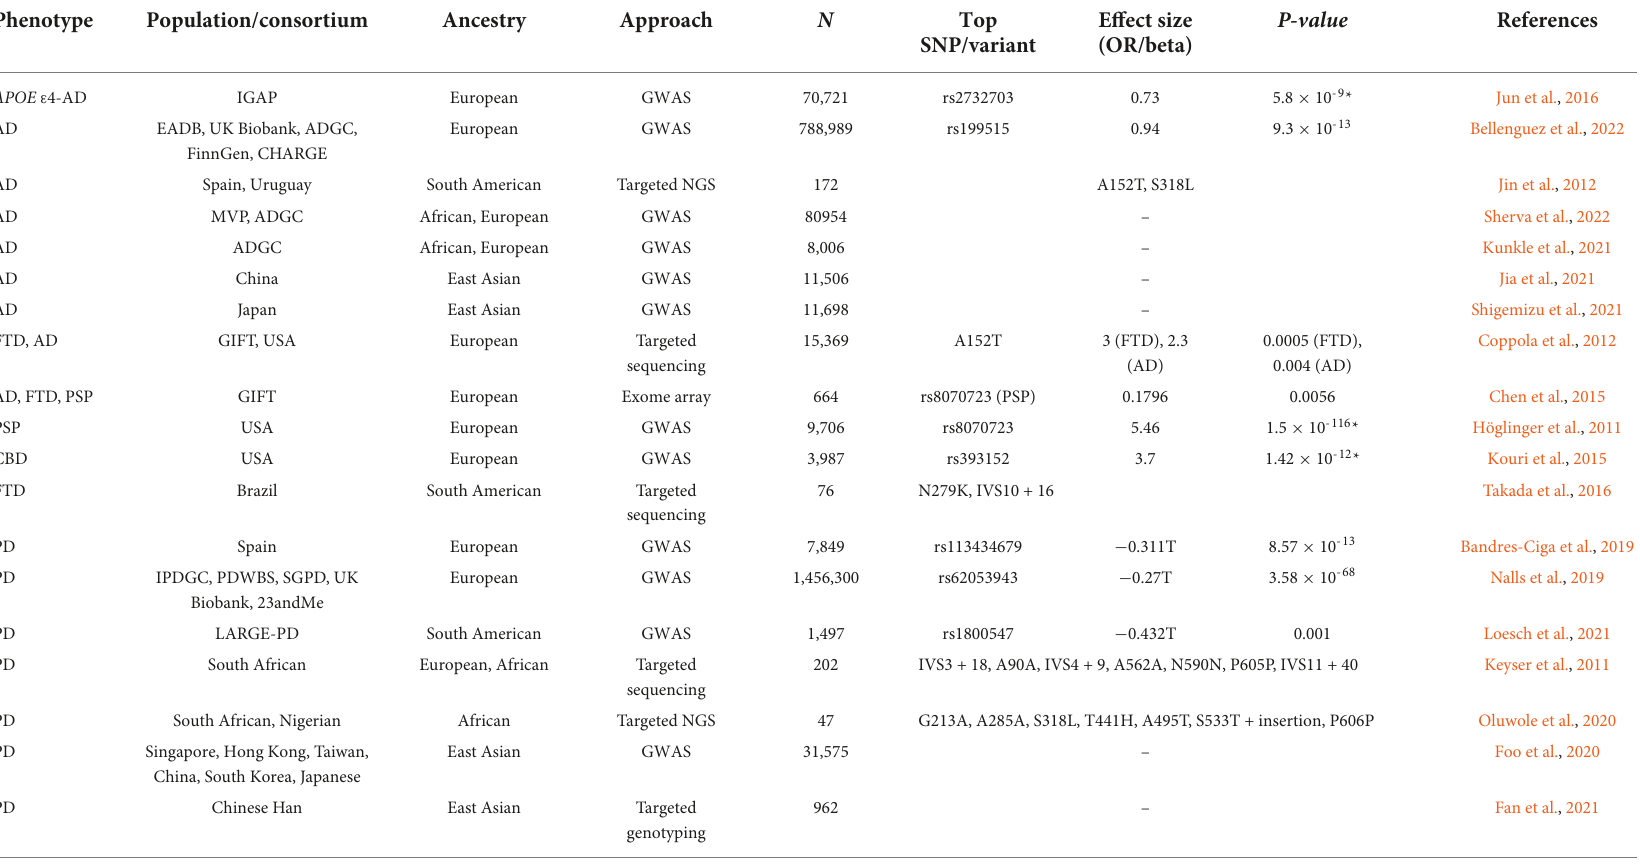
TABLE 1 Summary of 17q21.31 genetic association with neurodegenerative disease across global